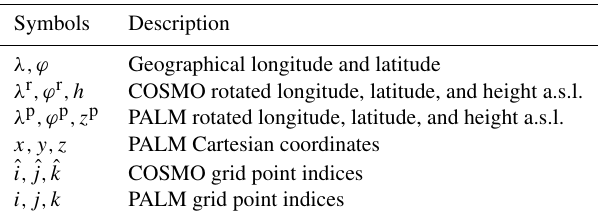
Table 3. Coordinate systems and grid